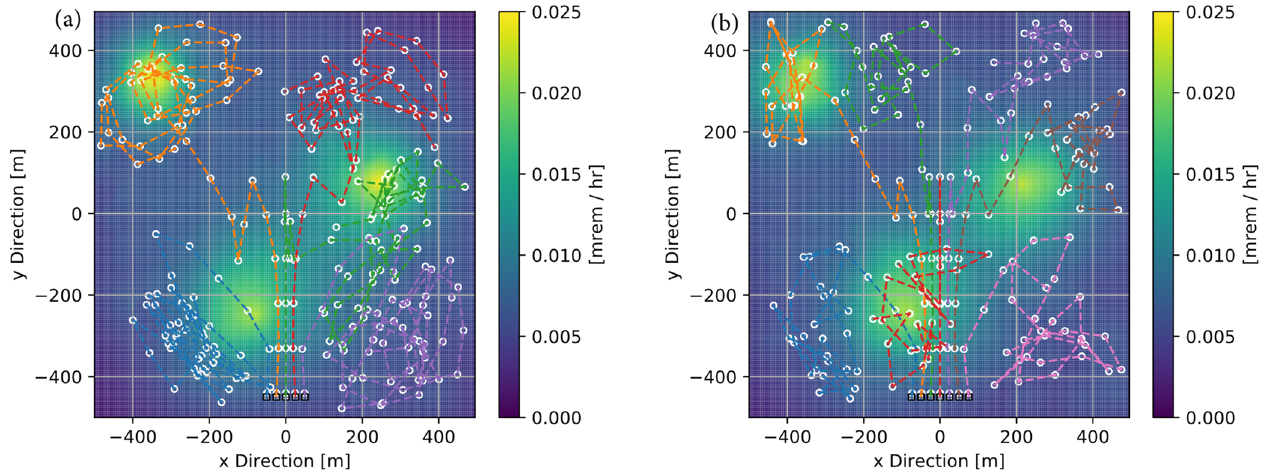
Figure 4. Seven-sensor survey results showing ( a ) the predicted distribution for E = 0.90 and ( b ) the grid-by-grid fractional difference to the true distribution shown in Figure 1.